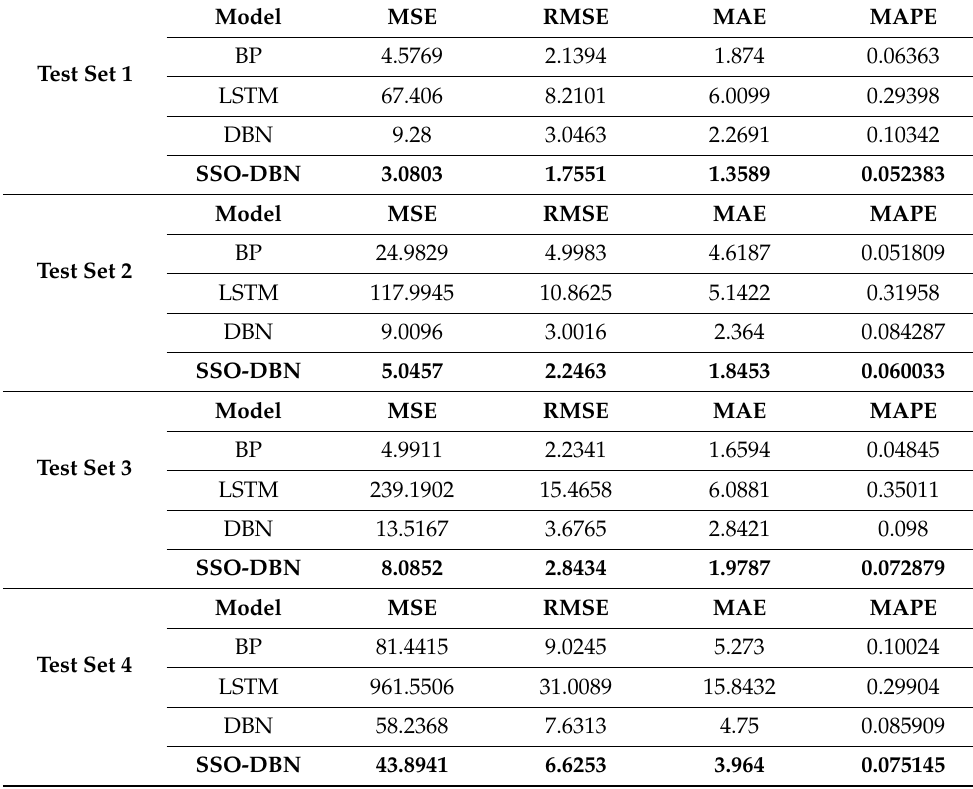
Table 6. Evaluation index results under different test